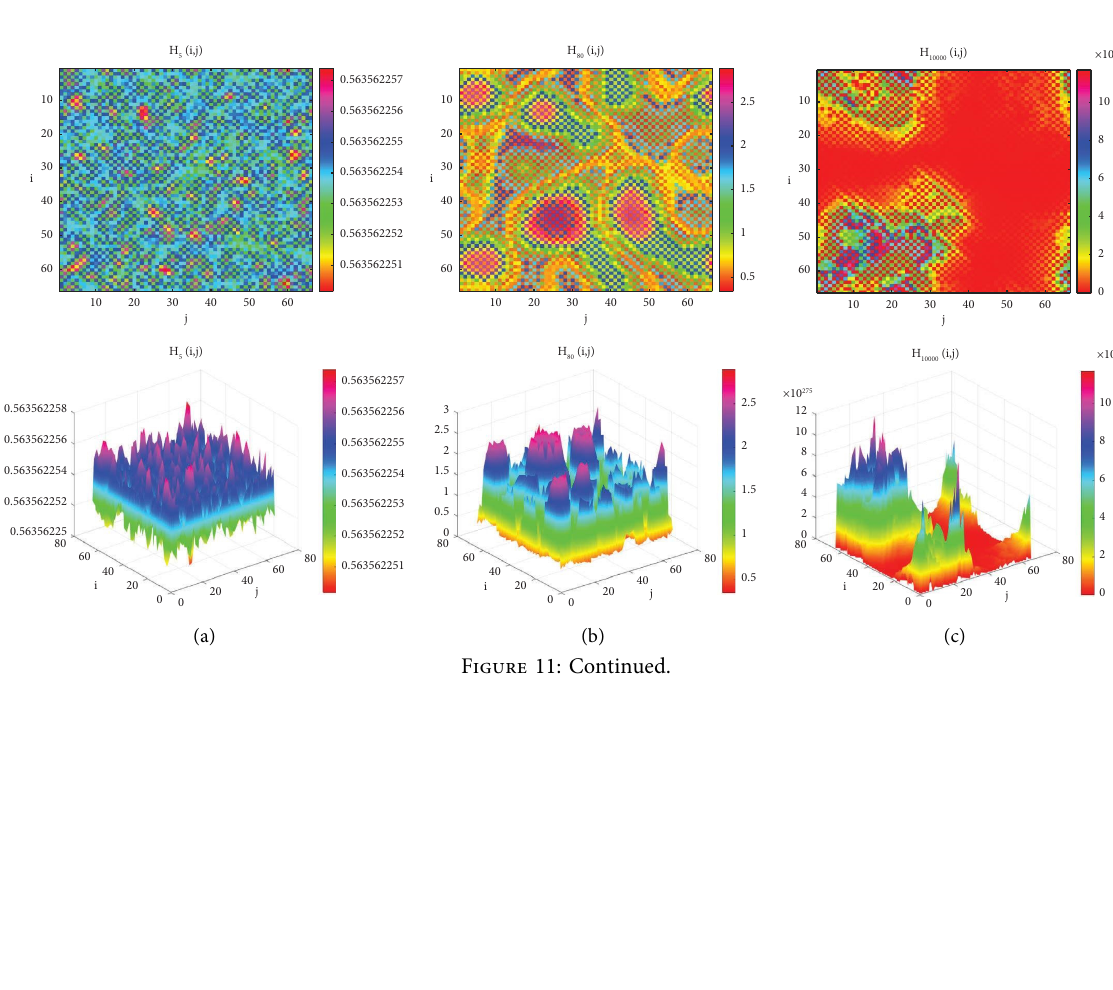
Figure 10: R � 2 , k � 1, c � 0 . 8, σ ∗ � 0 . 278655 ,d the case of Corollary 3(1), there exist a homogeneous stationary, parasite and host populations are maintained in a relatively stable state in two-dimensional space.